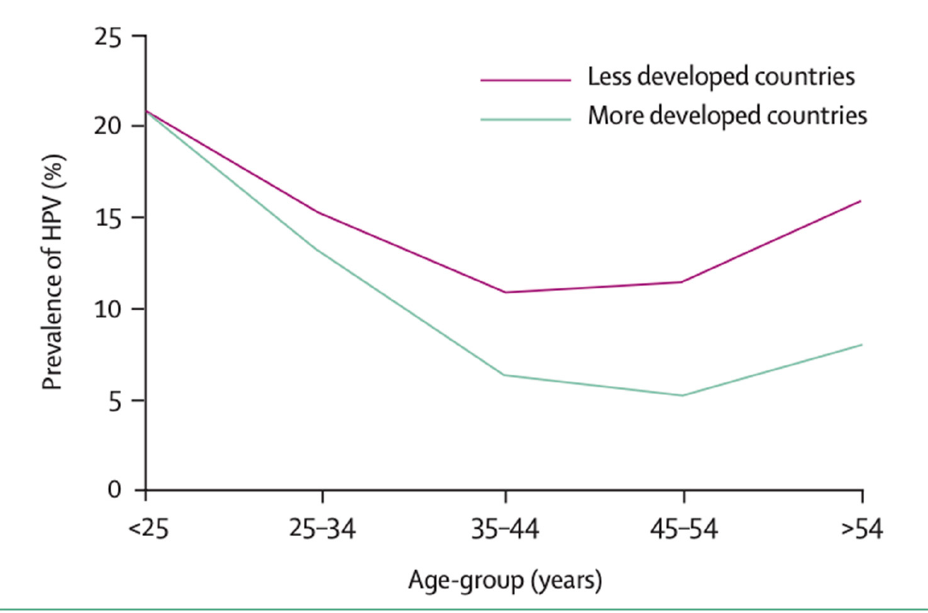
Figure 1. Prevalence of HPV worldwide by age (reproduced with permission from de Sanjosé et al. [11]). There are over 100 subtypes of HPV, characterised into high-risk and low-risk sub- types depending on oncogenic potential. Low-risk HPV subtypes include HPV-6, HPV-11, HPV-42, HPV-43 and HPV-44 [12]. HPV-6 and HPV-11 are the most prevalent nononco- genic subtypes and are responsible for over 90% of all cases of genital warts [13]. The oncogenic subtypes include HPV16, HPV-18, HPV-33, HPV-35, HPV-45 and HPV-58, and these have the potential to cause cervical, oropharyngeal, vaginal, vulvar, penile and anal cancers [12,14]. Cervical cancer is by far the most prevalent HPV-associated cancer, and HPV 16 is the most common causative subtype, followed by HPV-18 [14]. Jointly HPV-16 and HPV-18 account for approximately 70% of all cervical cancer cases